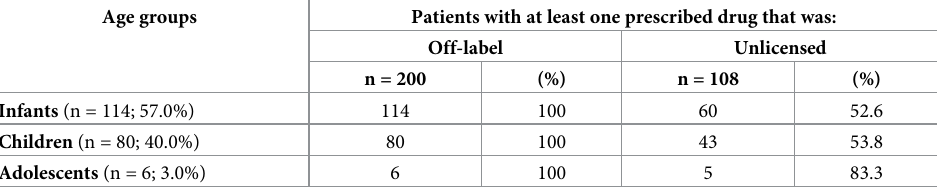
unlicensed medicine (Table 3). There appeared to be no difference between age groups in the proportion of patients who received at least one unlicensed drug (Fisher’s Exact test; p = 0.38). The distribution of off-label and unlicensed prescribing of the 1961 drugs in infants, children and adolescents is summarized in Table 4. While it appeared that the use of off-label drugs was more common for adolescents than infants, no significant association was evident between age-group and the use of off-label drugs (GEE model, univariate p = 0.090).